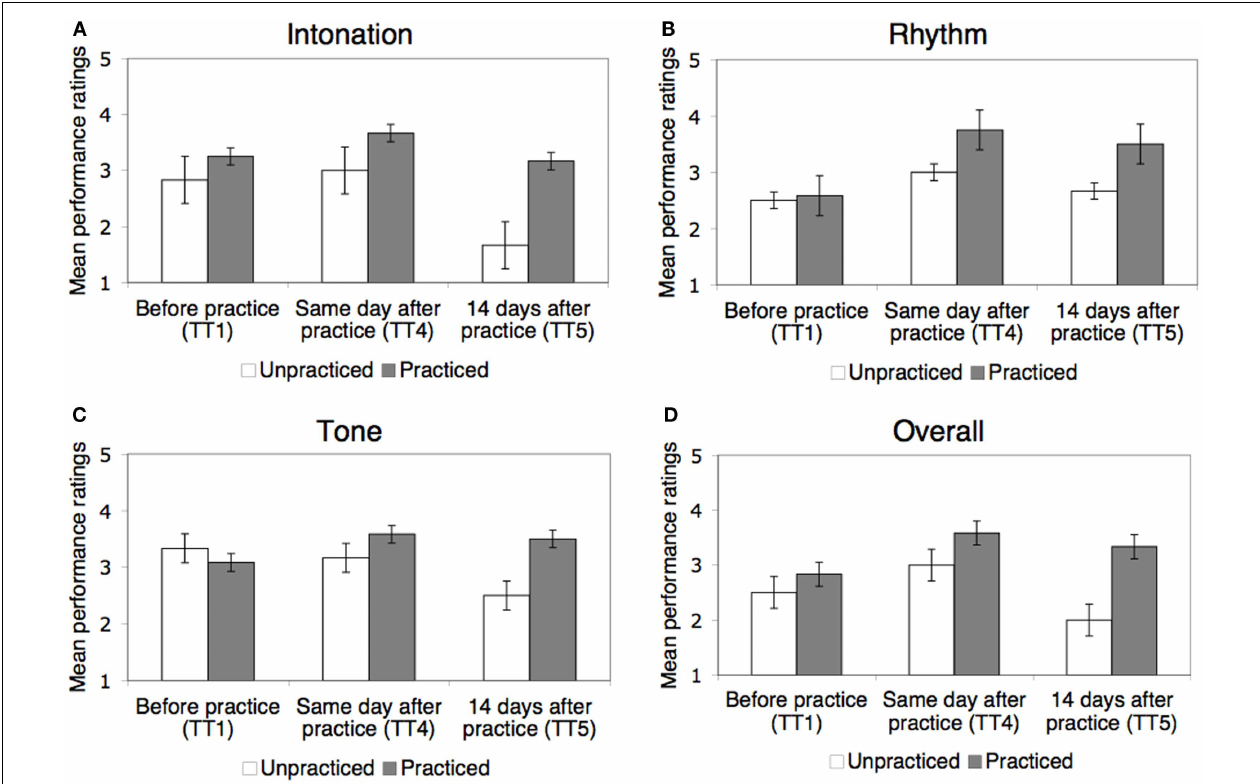
FIGURE 4 | LSJ’s music performance on practiced and unpracticed pieces before and after practice on the same day and after a 14-day delay (Test Trials 1, 4, and 5, respectively) as evaluated by experienced string players . Performance was evaluated on a 1–5 scale separately for intonation (A) , rhythm (B) , tone (C) , and overall (D) . Results were collapsed across the two practiced pieces, Piece A and Piece B. Error bars represent standard errors of the